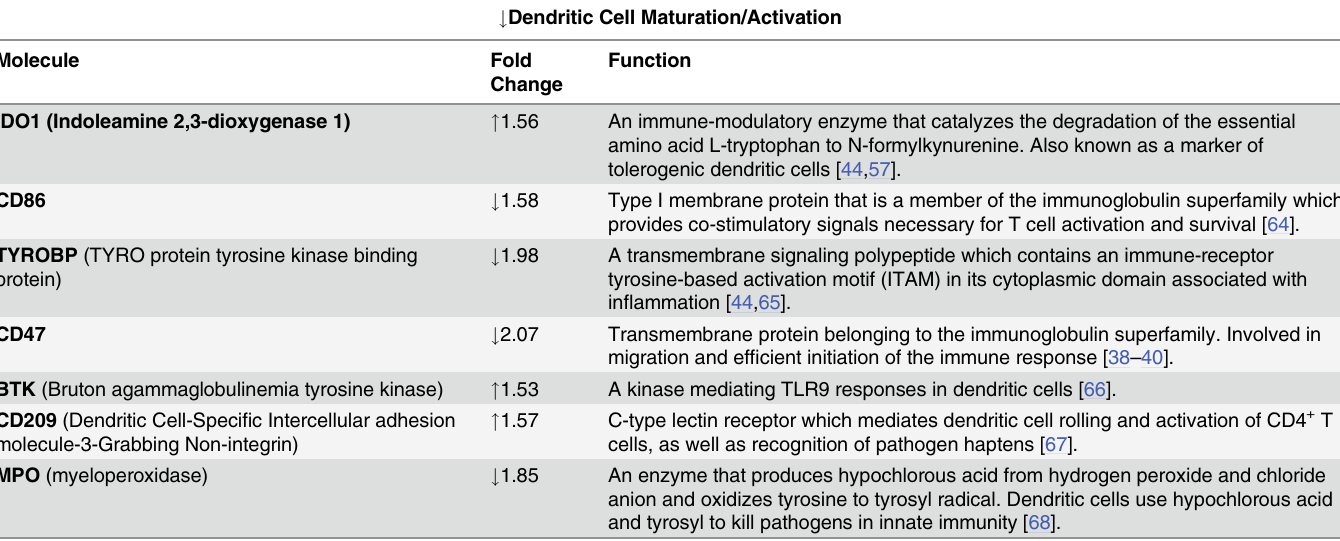
Table 1. Effect of CTB-INS on dendritic cell proteins associated with maturation and activation.